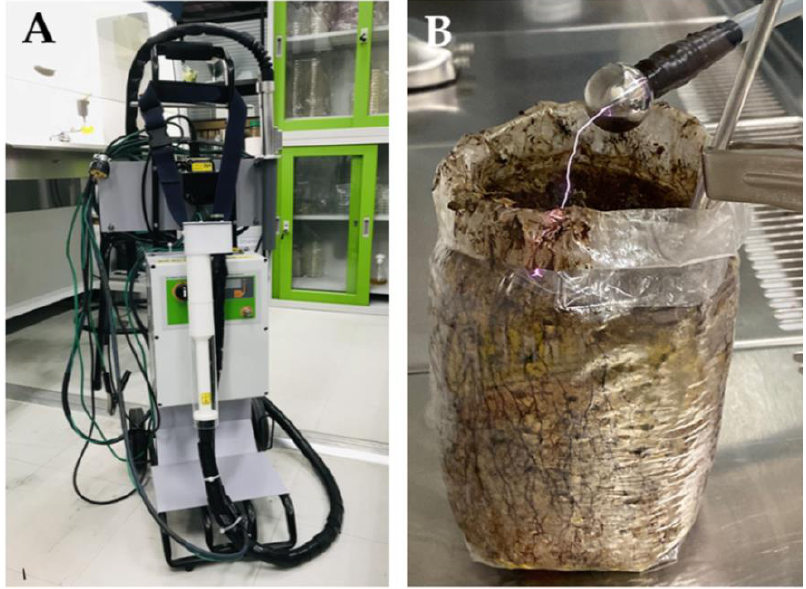
Figure 2. A high-voltage pulsed power generator ( A ) and the application of high-voltage pulses on the mushroom bag ( B ).